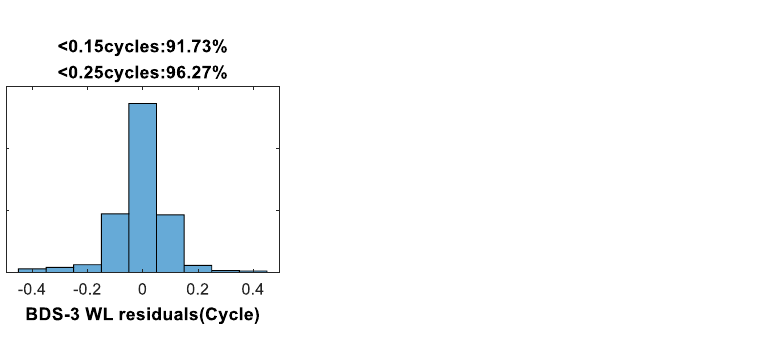
Figure 5. BDS-3 WL float ambiguity posteriori residual errors distribution (2021, day 185).